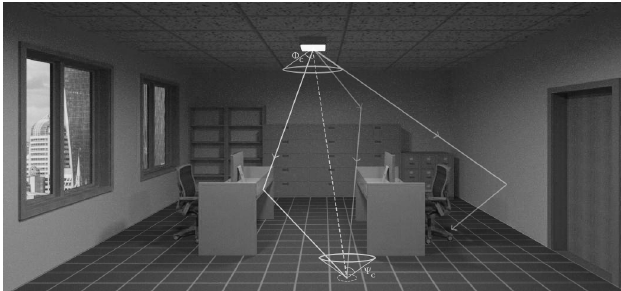
Figure 1. A schematic of the proposed indoor intruder tracking using visible light communication (VLC) showing three possible ray paths: line of sight (LOS), reflection from walls and furniture and blocked